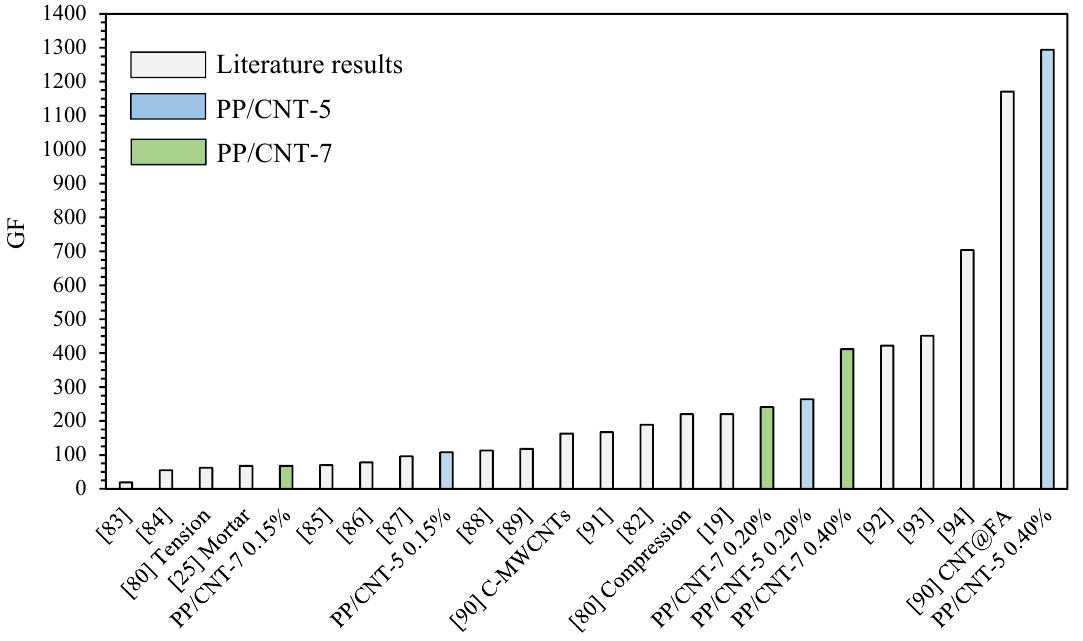
Figure 14. Comparison of the GF of di ff erent strain-sensing cementitious Figure 14: Comparison of the GF of different strain ‐ sensing cementitious materials.